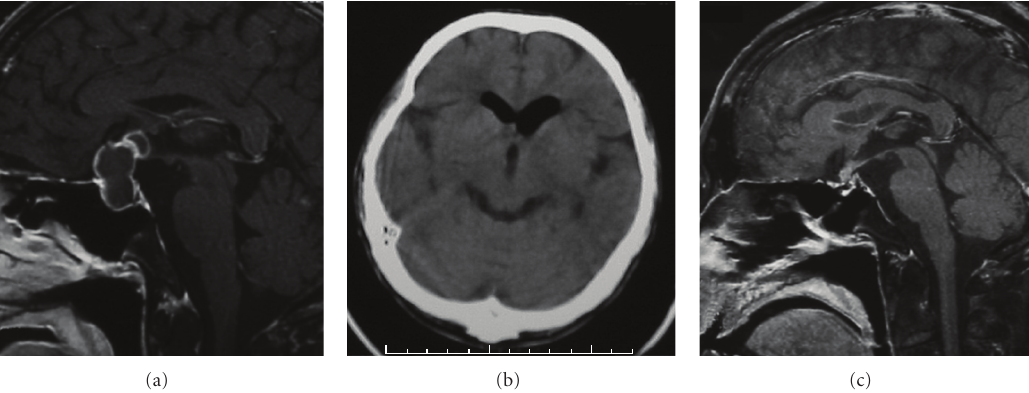
Figure 1: (a) Preoperative sagittal contrast-enhanced T1-weighted MRI demonstrating a ring-enhancing mass in the sella extending to the suprasellar legion. (b) Brain CT scan performed when the CSF rhinorrhea occurred (19 days after the operation) showing pneumocephalus. (c) MRI scan performed at the same time revealing no recurrence of abscess.